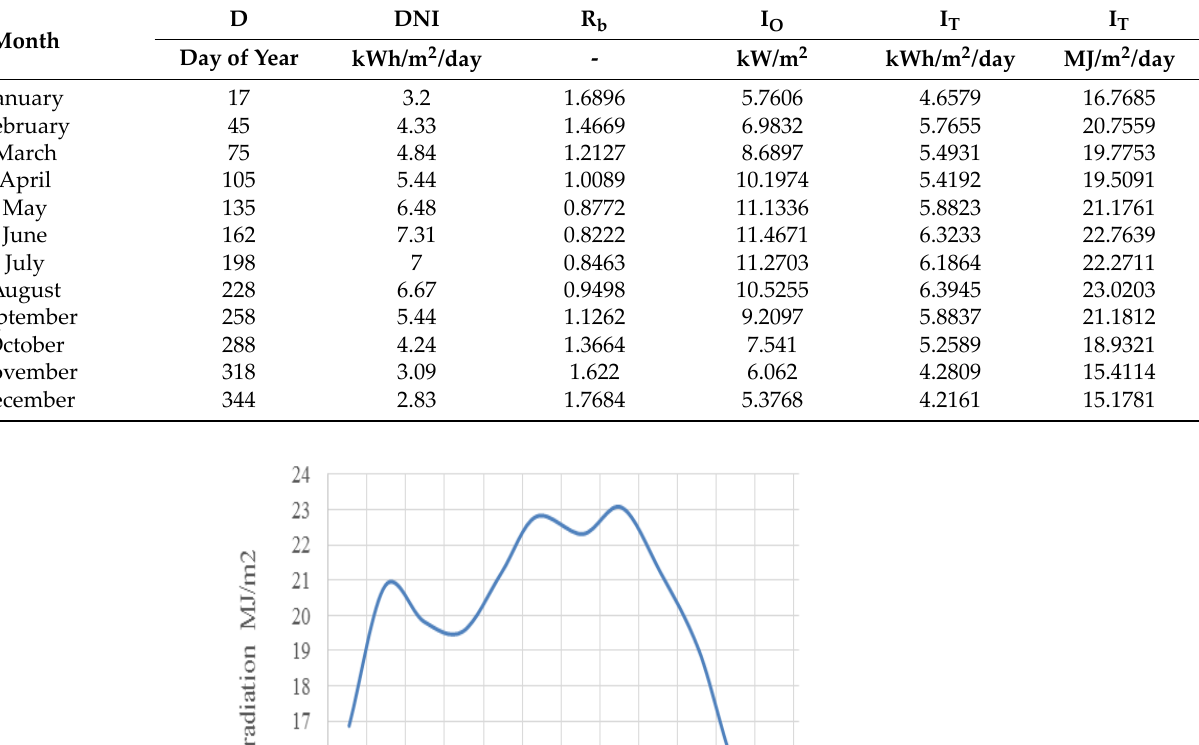
Figure 11. Monthly temperature in Ahvaz [80]. The normal direct radiation on the ramp for all months of the year is shown separately in Table 3 and the daily radiation in Figure 11. The daily radiation is compared in Figure 12 and the outlet temperature from the collector in similar researches in different lengths of the absorber tube in Figure 13. Table 3. Normal direct radiation on the ramp for all months of the year separately.